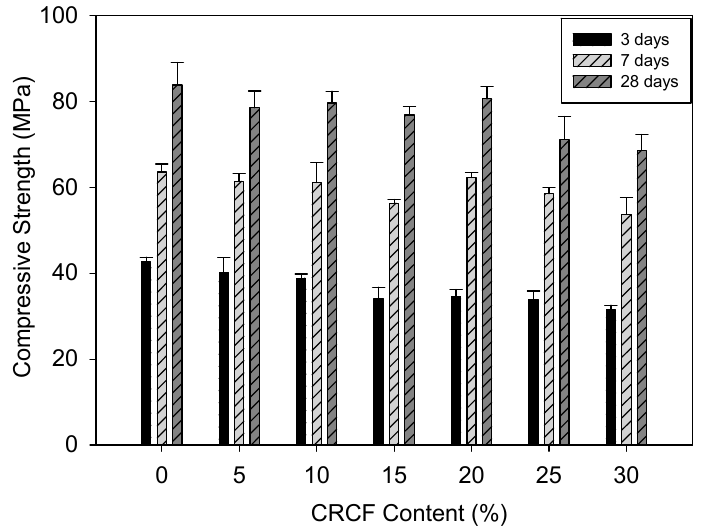
Figure 14. Compressive strength of cement samples with different CRCF contents.